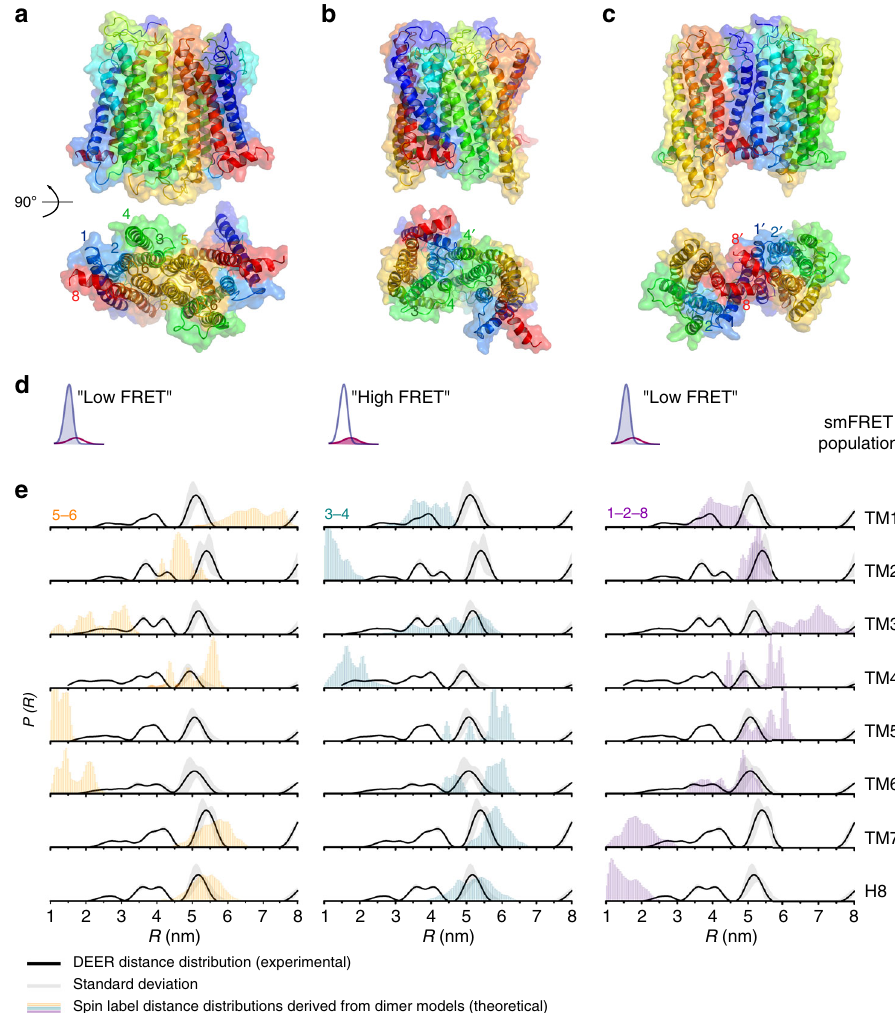
Fig. 5 Proposed oligomerisation interfaces. Linear combinations of a set of seven structural models of NTS1 dimers combining NTS1 crystal structure monomers (PDB 4BUO 26 ) with GPCR dimer crystal structure templates (Supplementary Fig. 12) were compared to the experimental FRET results (for